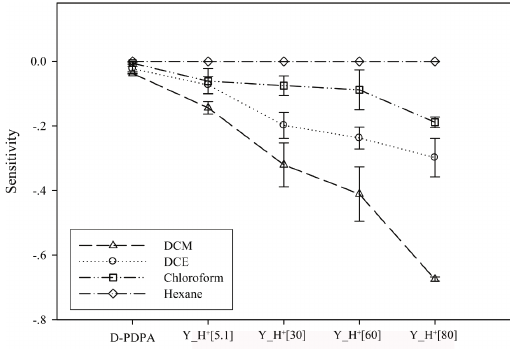
Figure 2. The sensitivity of D-PDPA, Y_H + at various Si/Al ratios when exposed to halogenated solvents at 27±1°C and 1